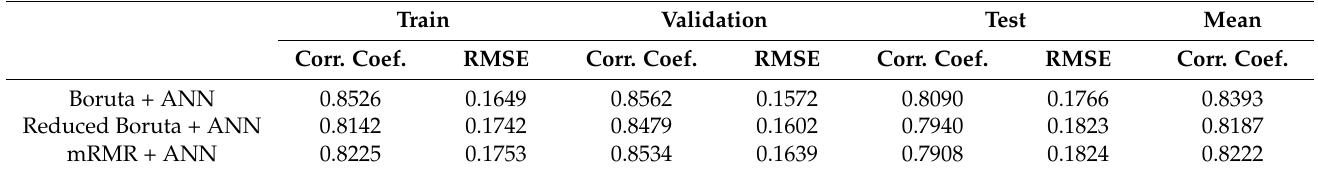
Table 5. ANN results for the best-performing models of noise interference with autonomous activities using the variables selected by Boruta, mRMR, and the set of reduced Boruta. The table shows the correlation coefficient and the root mean square error (RMSE) for the train, validation, and test sets. ANN Model of the Noise Interference while Performing Autonomous Academic Activities Train